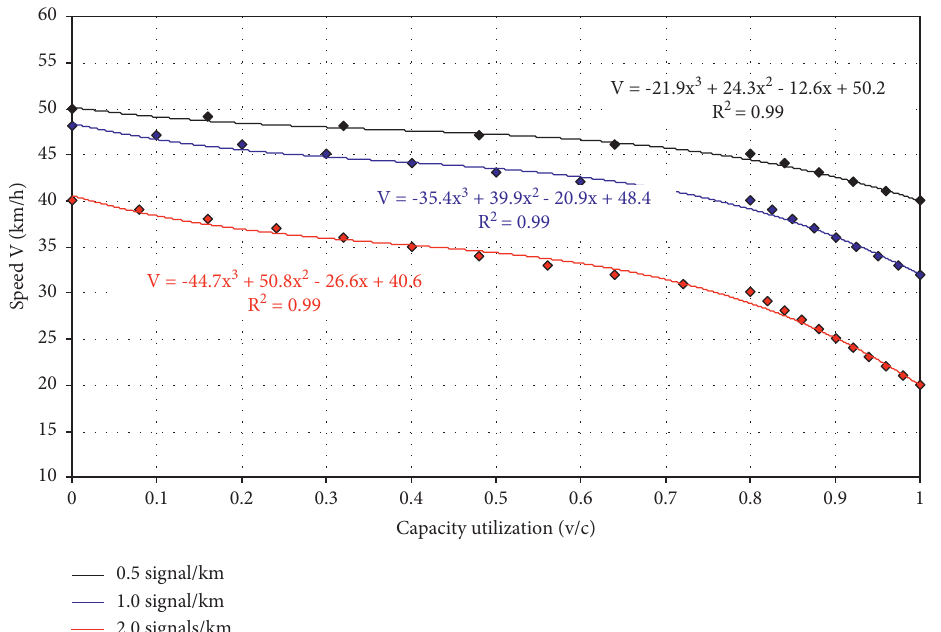
Figure 3: Legitimacy of the traffic flow speed change depending on the capacity utilization and the number of signalized intersections by a kilometer of the